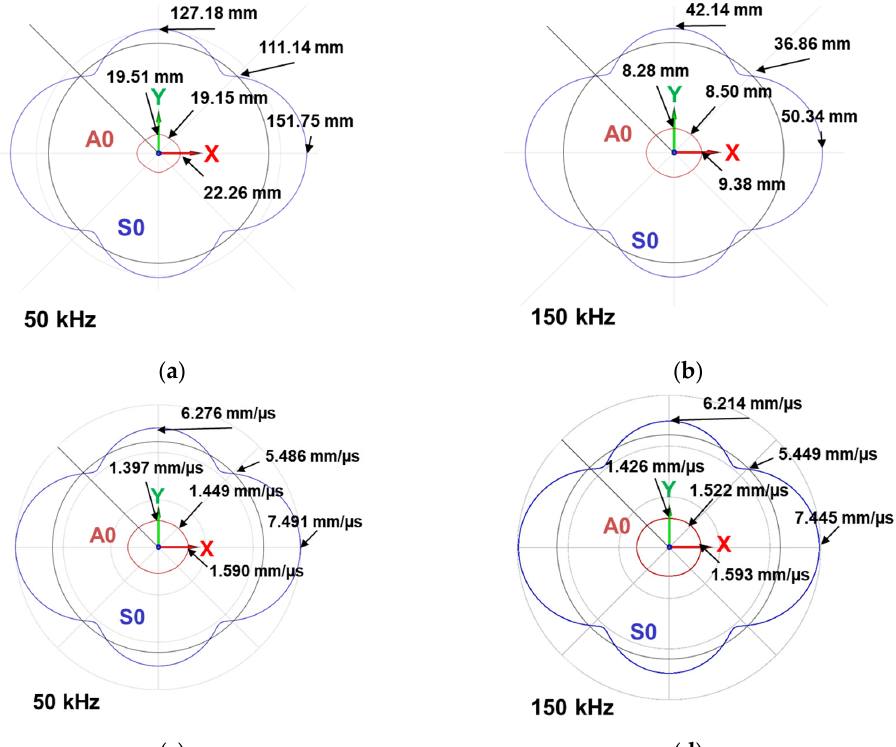
Figure 4. Semi-analytical finite element calculation modes in a polar diagram representation for the experimentally stacked composite, in wavelength (mm) ( a ) at 50 kHz and ( b ) at 150 kHz, and in energy velocity ( c ) at 50 kHz and ( d ) at 150 kHz (2.63 mm of thickness–400 × 400 mm 2 ).